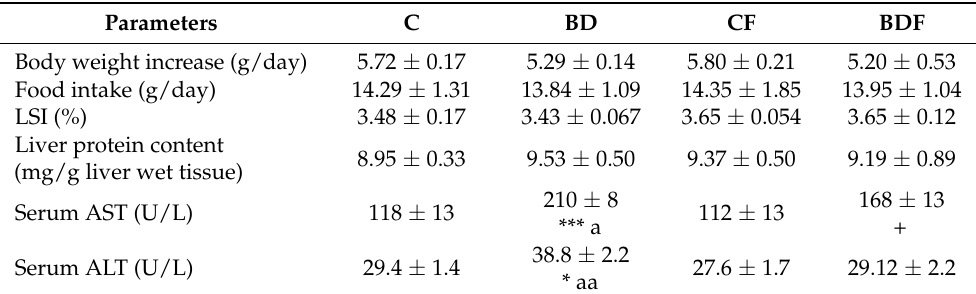
Table 1. Nutritional and hepatic